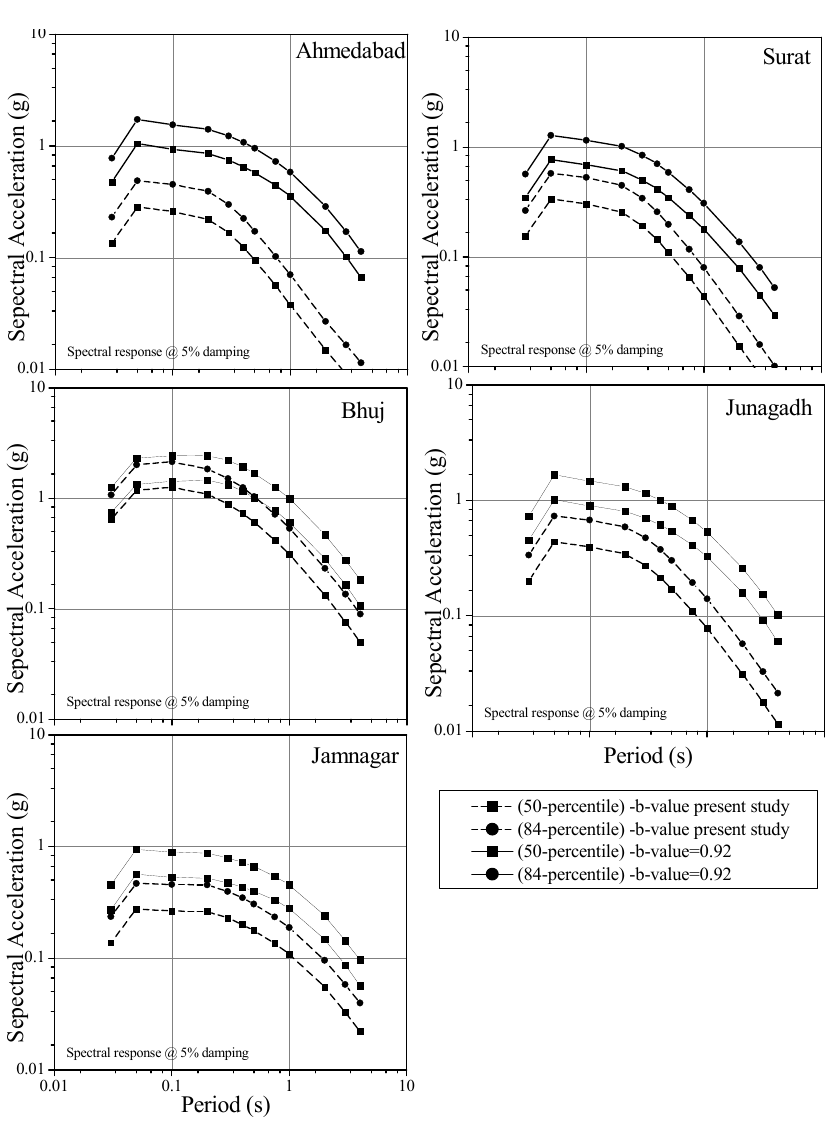
Fig. 12. Deterministic spectra obtained for various cities with different b -values. The ground accelerations are plotted in unit of 5% damped acceleration response spectrum as a function of period for different b -values at particular site Figure 12. Deterministic spectra obtained for various cities with different b-value s. Plotted 3 are the ground accelerations in unit of 5% damped acceleration response spectrum as a 4 function of period for different b-value s at particular site location. 5